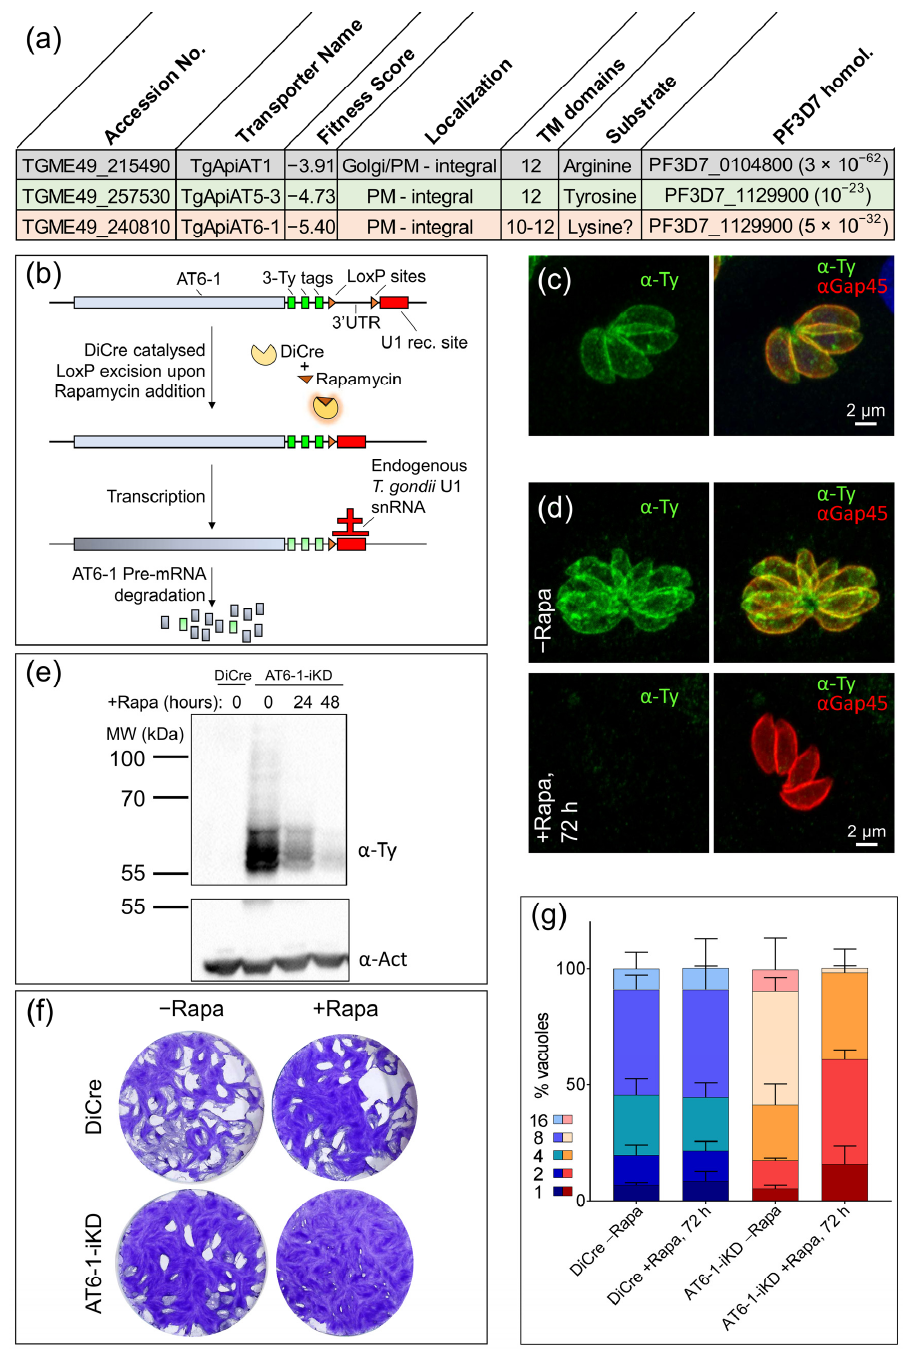
Figure 1. AT6-1 is an essential plasma membrane transporter. ( a ) Overview of known amino acid transporters in T. gondii . TgApiAT1 and TgApiAT5-3 were identified as arginine and tyrosine transporters, respectively [11,12] . TgApiAT6-1 was recently putatively characterized as a lysine transporter [26,27]. ( b ) Cartoon scheme of AT6-1 locus modification by introducing a 3-Ty-tag, loxP sites and a U1 recognition site, enabling localization of AT6-1 and its conditional down- regulation. ( c ) Immunofluorescence assay (IFA) to determine the localization of AT6-1 (Ty, green) with the pellicle marker GAP45 as a reference for the cell periphery (red). ( d ) IFA of AT6-1 control and following 72 h of rapamycin treatment. ( e ) Western blot showing signal for AT6-1 (Ty) after 24 and 48 h of rapamycin treatment. Antibodies against actin were used as a loading control ( α -Act). ( f ) Lysis plaques of parasites lacking AT6-1 (+Rapa) and controls following one week of growth. ( g ) Intracellular growth assay of parasites depleted in AT6-1 and controls. Growth (number of parasites per vacuole) was assessed over 24 h, following 48 h of rapamycin pre-treatment (72 h rapamycin